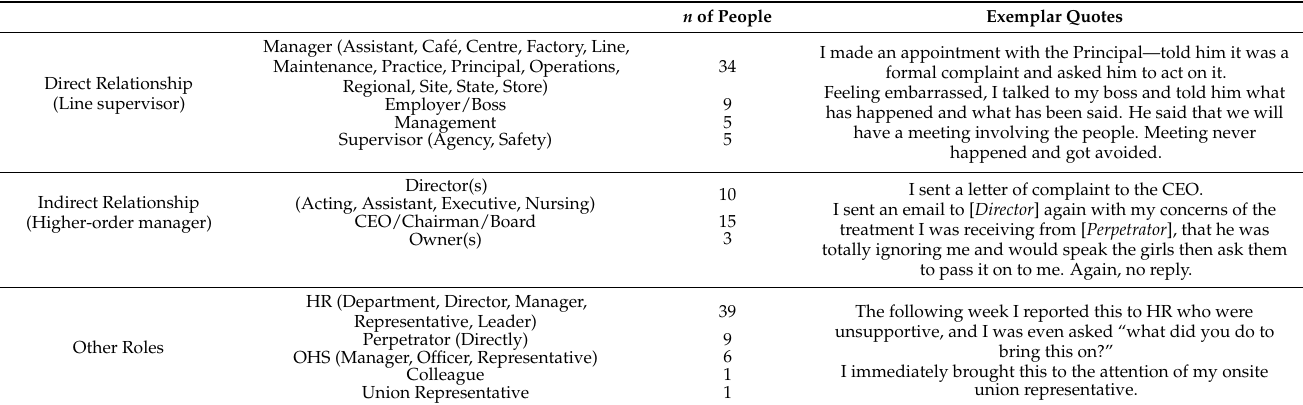
Table 3. Position of the Person Who the Bullying Was Reported to Internally. n of